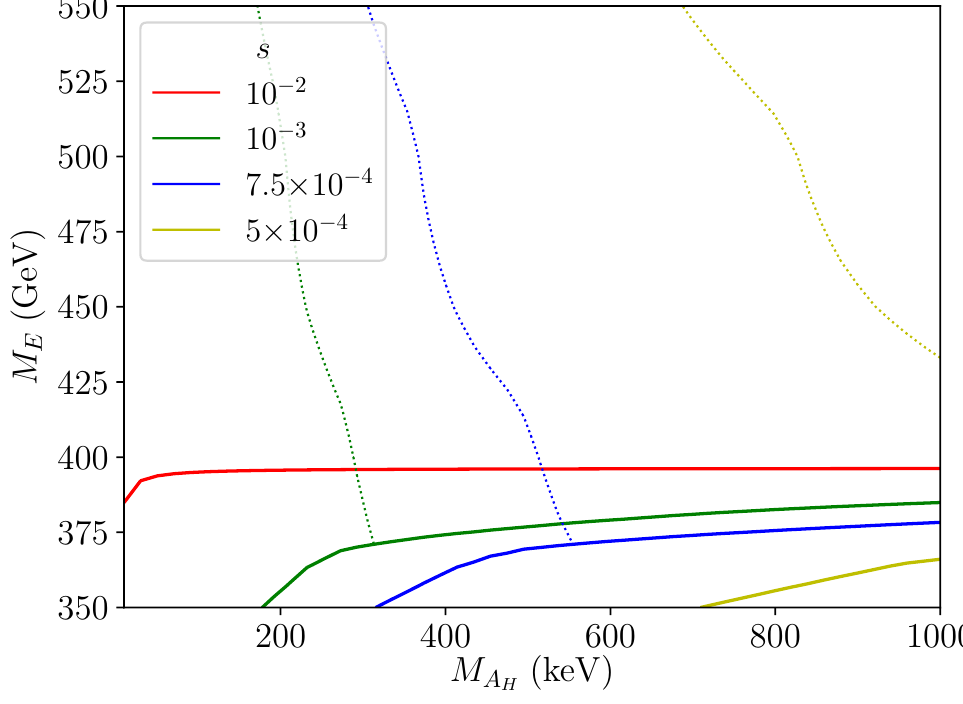
√ Figure 20 . Contours of collider limits, for the LHC with s = 13 TeV and L = 139 fb − 1 , on models that generate the observed DM relic abundance via the freeze-in mechanism for different values of the fermion mixing parameter s . The region below the curves is excluded by collider searches, either targeting SM decays (solid) or decays into missing energy (dotted). See text and appendix A for